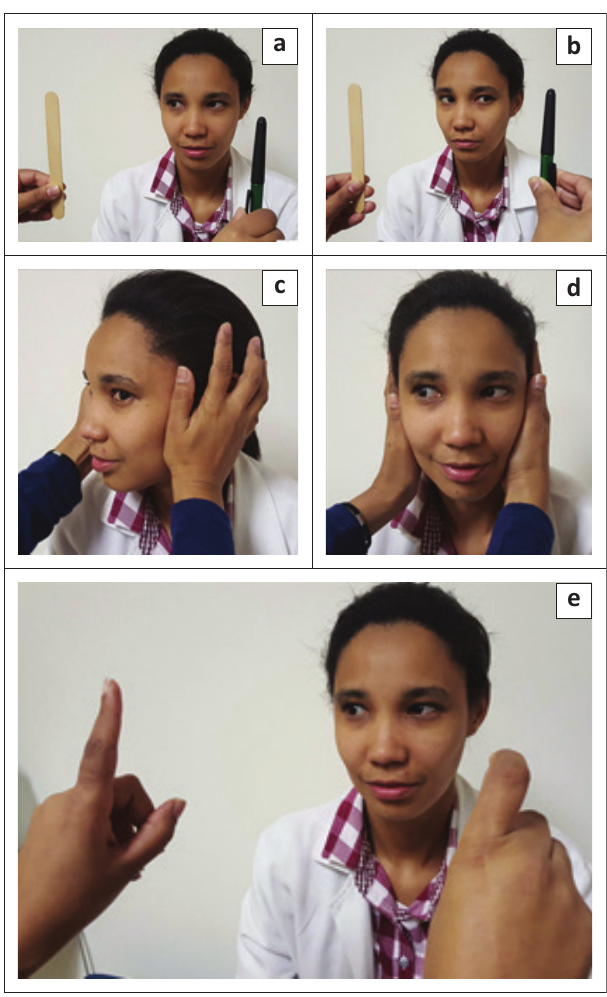
FIGURE 4: (a and b) Quick saccadic movements between two horizontal targets. (c and d) The vestibulo-ocular reflex in both directions. (e) Anti-saccadic movements made opposite to the finger